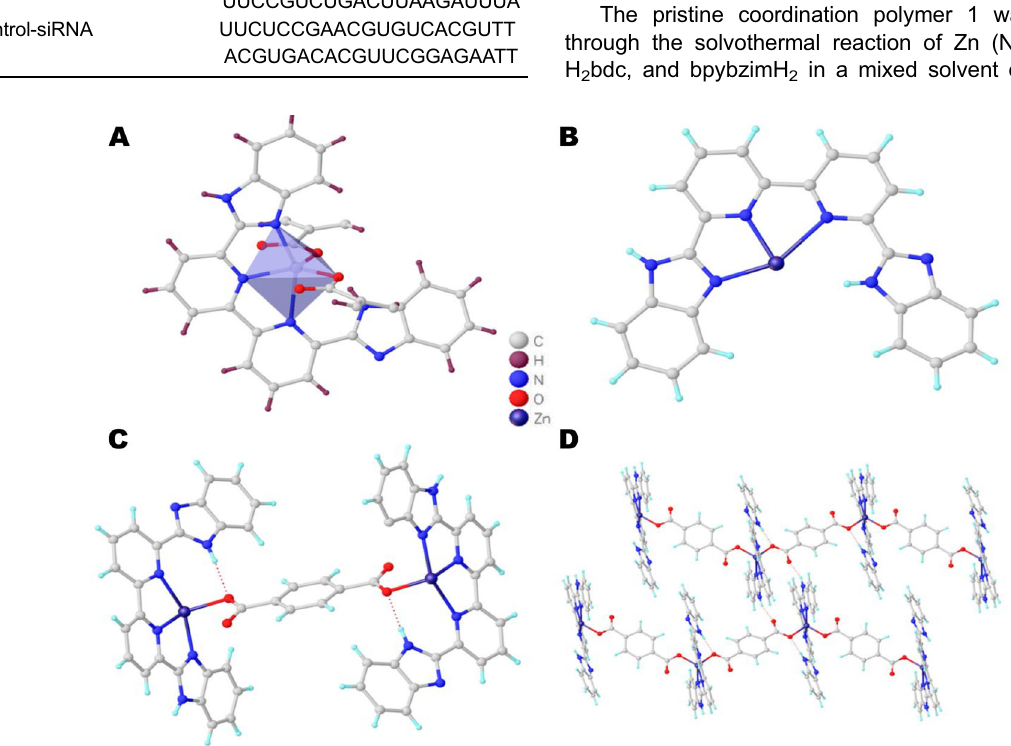
Figure 2. A , Molecular unit of complex 1. B , Binding pattern for the bpybzimH 2 ligand. C , Binding pattern for the bdc 2- ligand. D , H-binding interaction between the adjacent